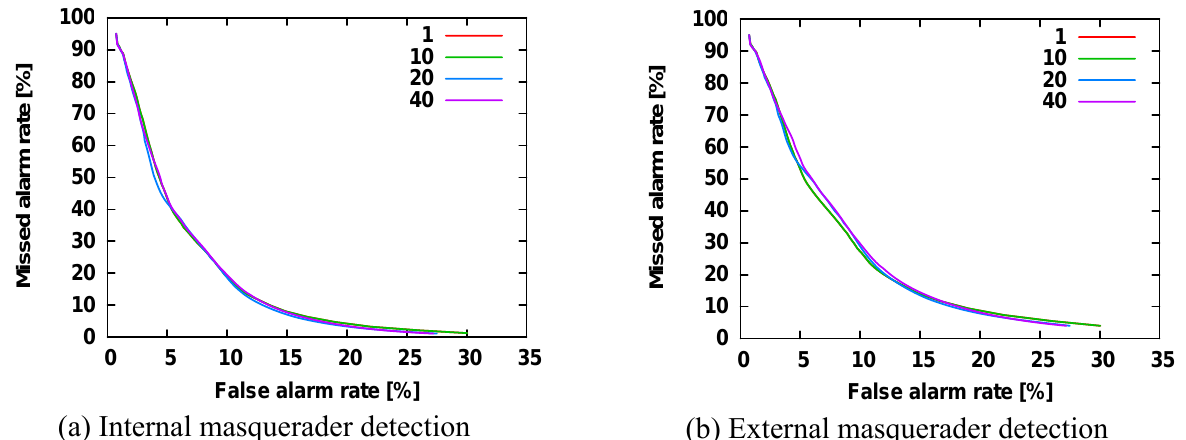
Figure 8. ROC curves for internal masquerader detection (a) and external masquerader detection (b) for the number of hidden states. All other parameters are the same as those in Figure 3.